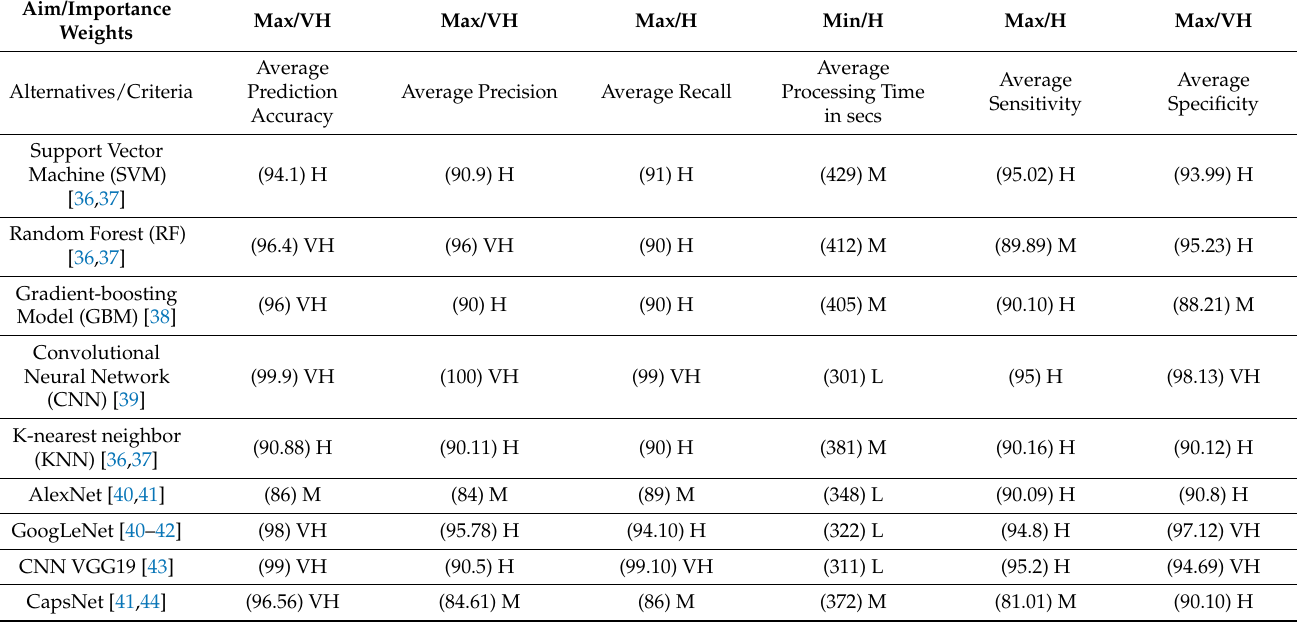
Table 2. Dataset for evaluating ML models used for brain cancer